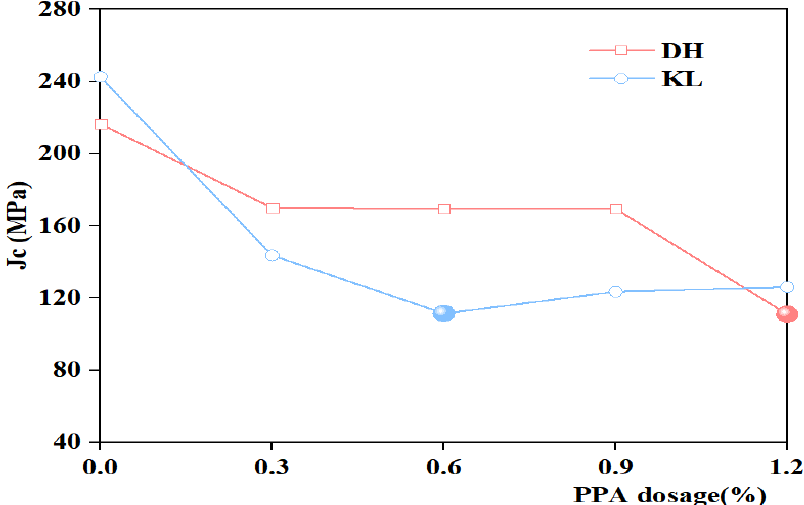
Figure 14. The Jc value of single modified asphalt with different PPA dosages.